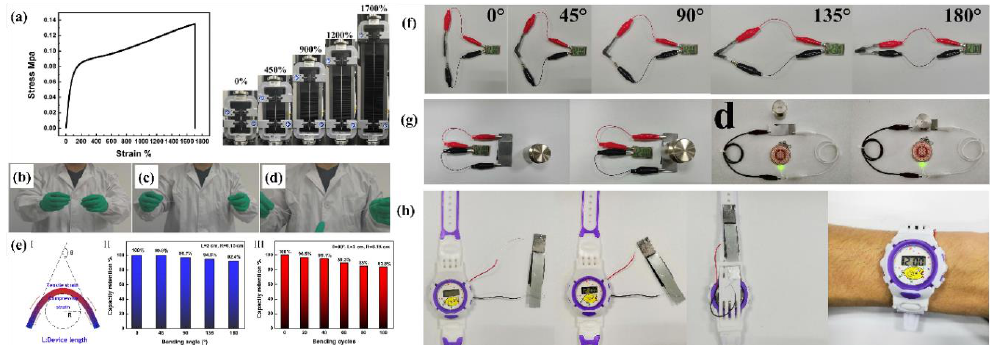
Figure 19. The comparison of ( a ) tensile strength and elongation at break and ( b ) toughness of HA-GPE-x. ( c ) Digital images of HA-GPE-1M with high flexibility (left) and stretchability (right). Cycling ( d ) tensile stress–strain and ( e ) compressive stress–strain curves of HA-GPE at a strain of 400% and 95% and corresponding recovery ratio. ( f ) Tensile stress–strain curves of HA-GPE-x with different LiClO 4 concentrations. ( g ) Cyclic voltammetry (CV) curves at normal and varied bending angles (45 ◦ , 90 ◦ ). ( h ) Cycling performance collected for the current density of 1 Ag − 1 (black: capacity retention; red: Coulombic e ffi ciency as a function of cycle number) [192].